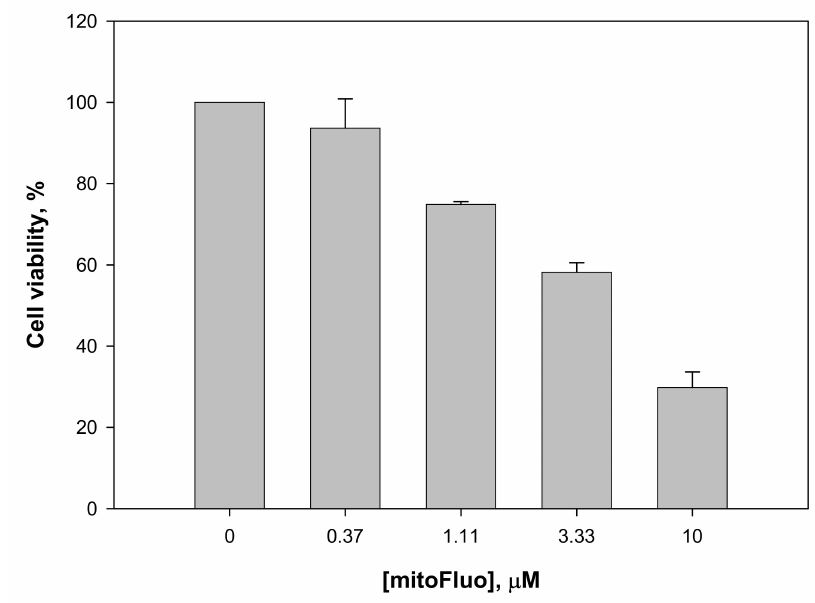
Figure 8. The viability of Rko cells in the presence of mitoFluo. Rko cells were incubated with mitoFluo for 17 h. The cell viability was determined with the Cell Titer-Blue reagent (Promega). The data are the mean ± SD of at least three